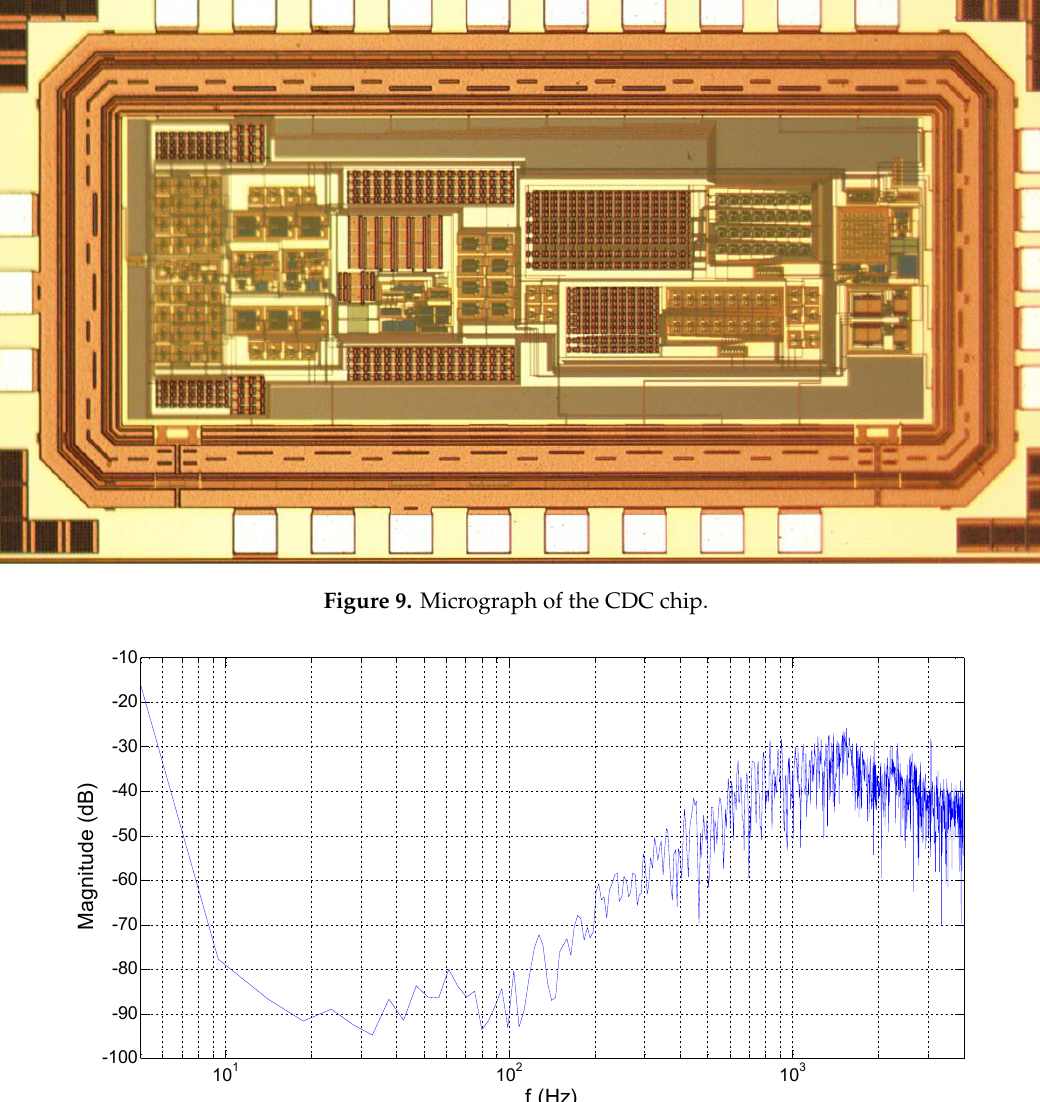
Figure 10. Output spectrum of the bitstream.